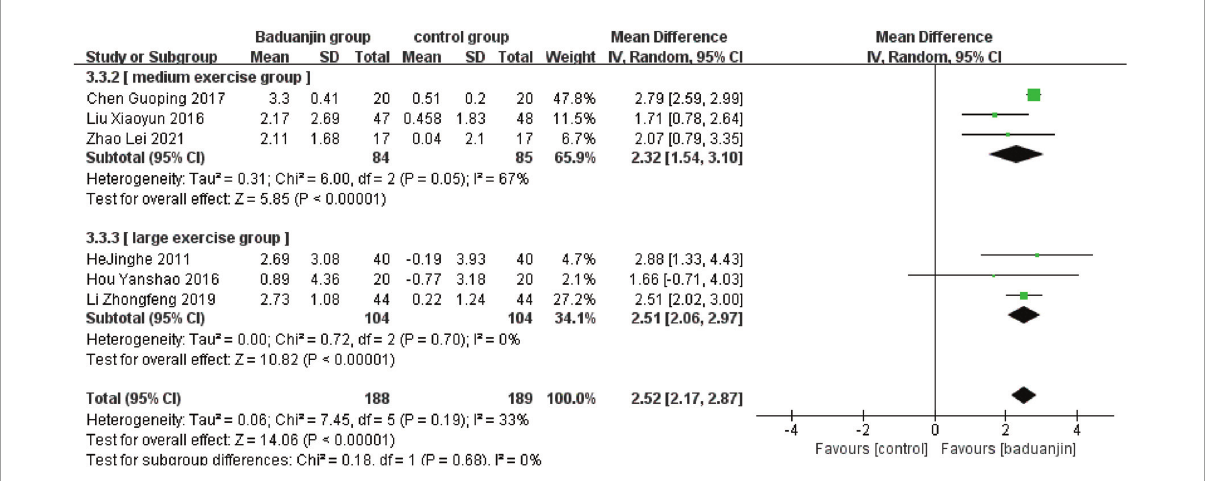
FIGURE11 Forest plot of the subgroup analysis of ECLSB for the total exercise amount. CI, confidence interval; SD, standard deviation.